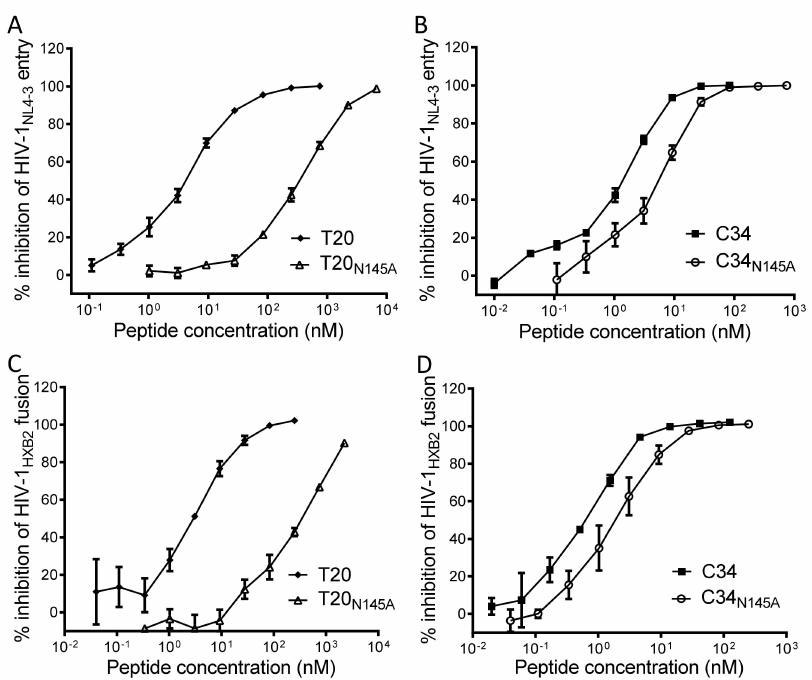
Figure 6. E ff ects of the N145A mutation on the anti-HIV activity of C-terminal heptad repeats (CHR-derived) fusion inhibitors. The inhibitory activities of T20 and T20 N145A ( A ) C34 and C34 N145A ( B ) on HIV-1 NL4-3 pseudovirus were compared by a single-cycle infection assay. The inhibitory activities of T20 and T20 N145A ( C ) C34 and C34 N145A ( D ) on HIV-1 HXB2 Env-mediated cell-cell fusion were compared by a reporter gene assay with TZM-bl cells as a target and HL2 / 3 cells as an e ff ector. The experiments were conducted in triplicate and repeated three times. Percent inhibition of the inhibitors and IC 50 values were calculated. Data are expressed as means ±